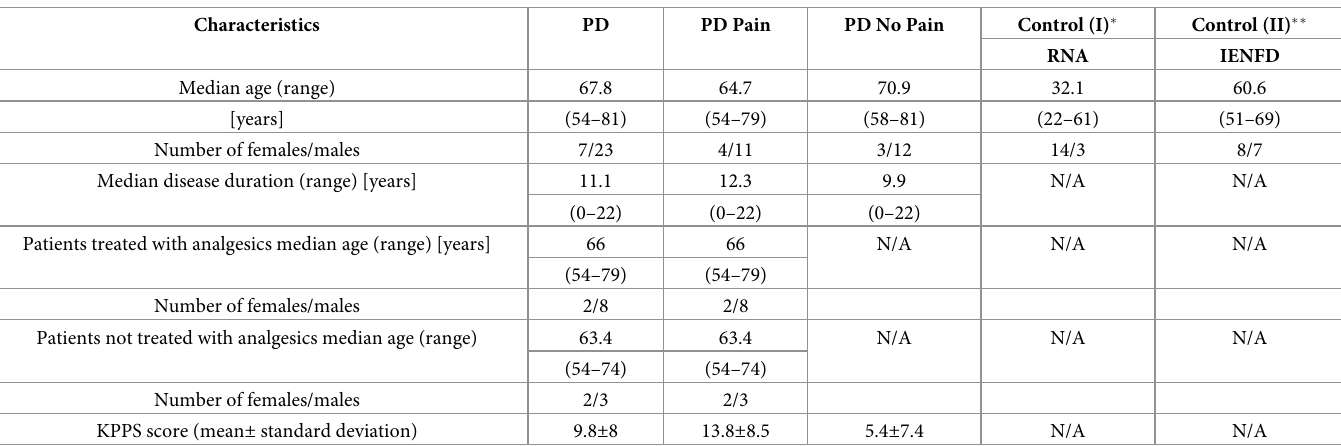
Table 1. Demographic data of study